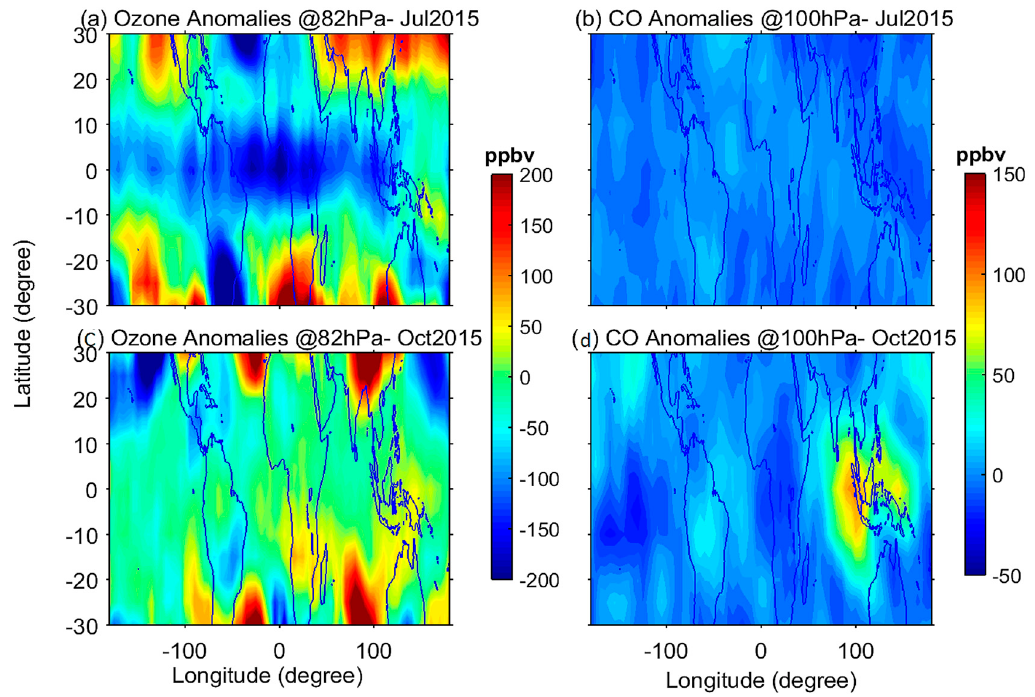
Figure 6. Spatial distribution of ozone anomalies observed at 82 hPa in ( a ) July 2015 and ( c ) October 2015. ( b , d ) same as ( a , c ), respectively but for carbon monoxide anomalies observed at 100 hPa. Anomalies are calculated by removing the background climatology (January 2006–December 2014) of individual months.